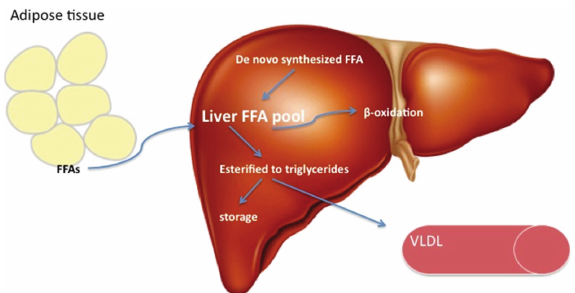
Figure 1: Lipid metabolism in liver. Liver FFA pool is derived from uptake of circulating FFAs and de novo synthesis. The FFAs are then either oxidized or esterified into triglycerides. Triglycerides are then released into circulation as VLDL or stored as vacuoles leading to hepatic